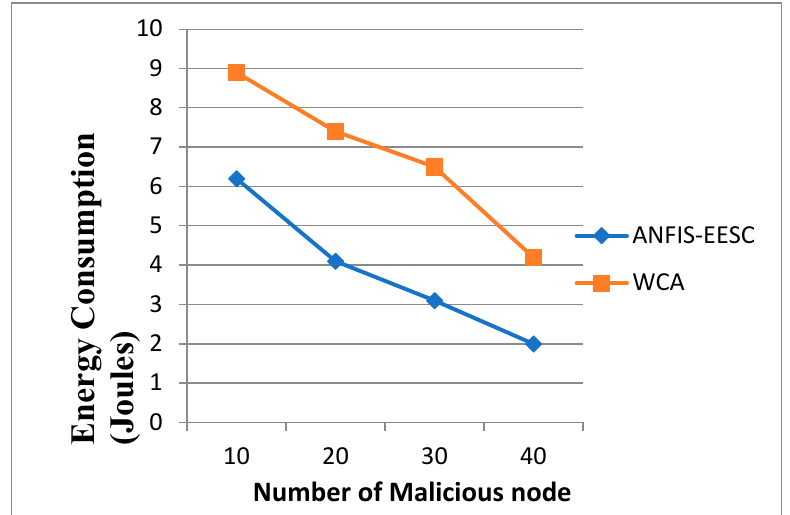
Figure 4. Energy consumption.